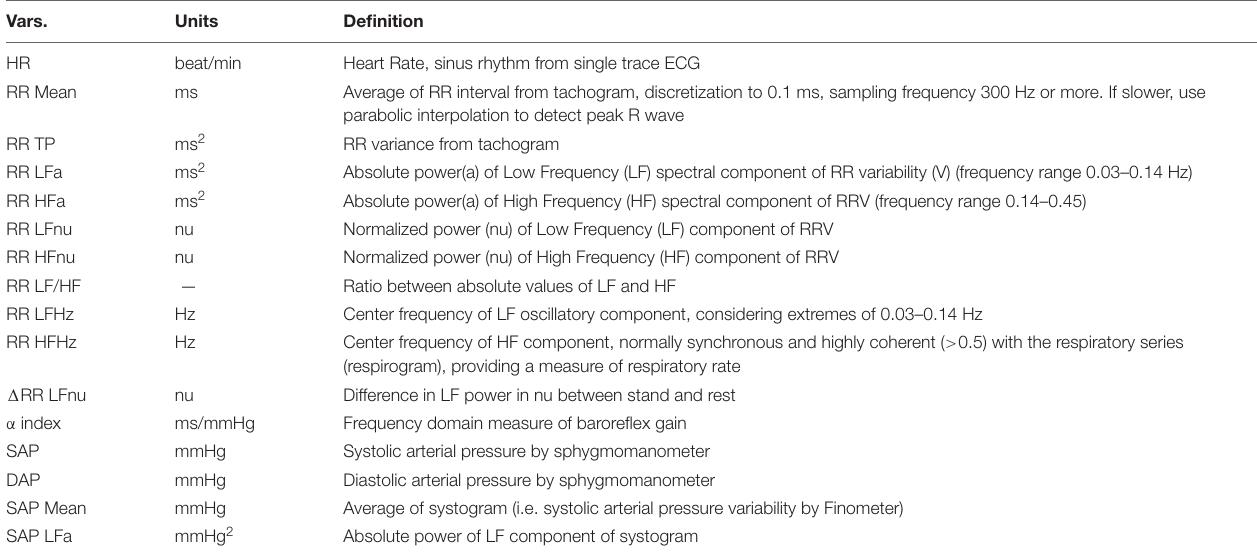
TABLE 2 | Definition of the variables (ANS proxies) utilized for the study ( a ) .